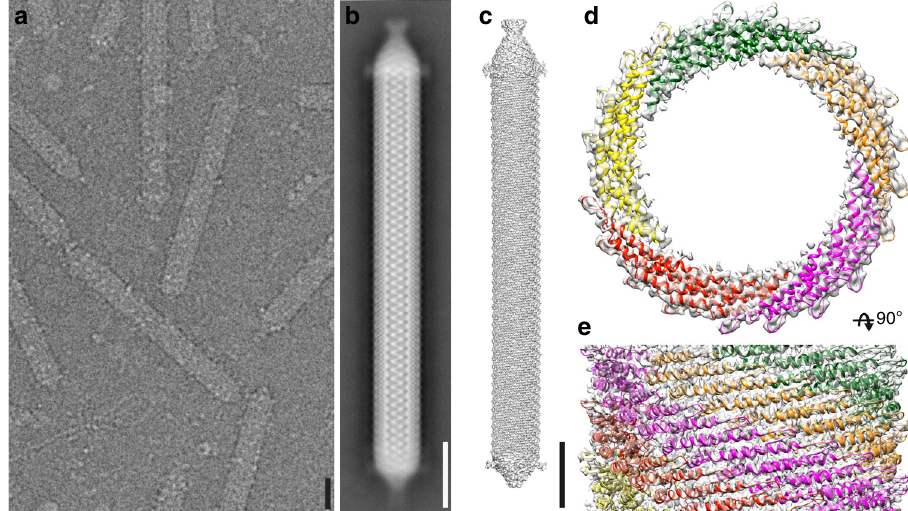
Fig. 1 Cryo-EM and 3D reconstruction of APBV1. a Cryo-electron micrograph showing APBV1 viral particles in vitrous ice. Scale bar 10 nm. b 2D class average of the whole APBV1 particle. Scale bar 10 nm. c Three-dimensional model of complete APBV1 particle is shown from the side. Scale bar 10 nm. d , e Top ( d ) and side ( e ) view of APBV1 map (transparent surface) and model of the major capsid protein VP1. VP1 subunits related by C5 symmetry are colored in red, yellow, green, orange, and